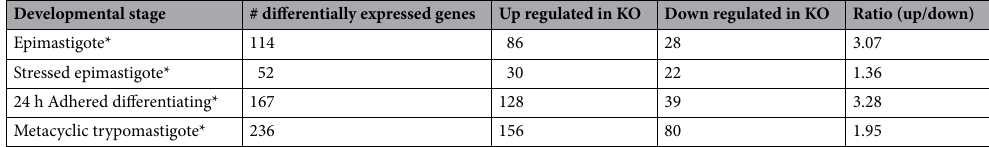
Table 1. Summary of genes differentially expressed in TcHDAC4 knockout samples at each developmental stage. *FDR ≤